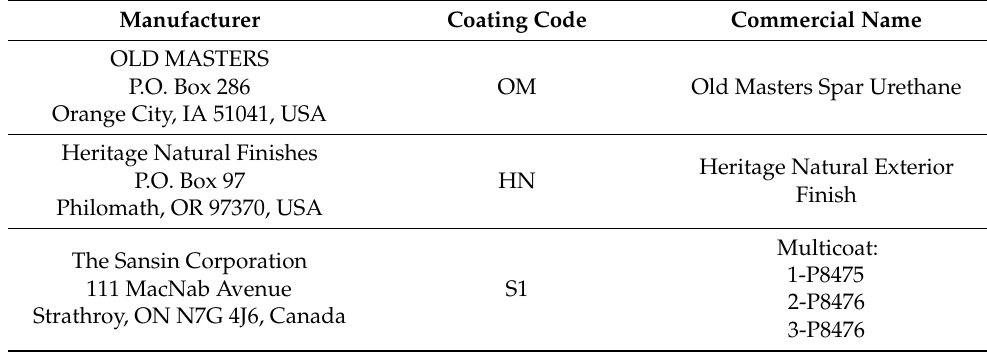
Table 1. Coatings used to evaluate the effects of the test site on the ability to protect against color change in Douglas fir and acetylated radiata pine in an aboveground field trial.